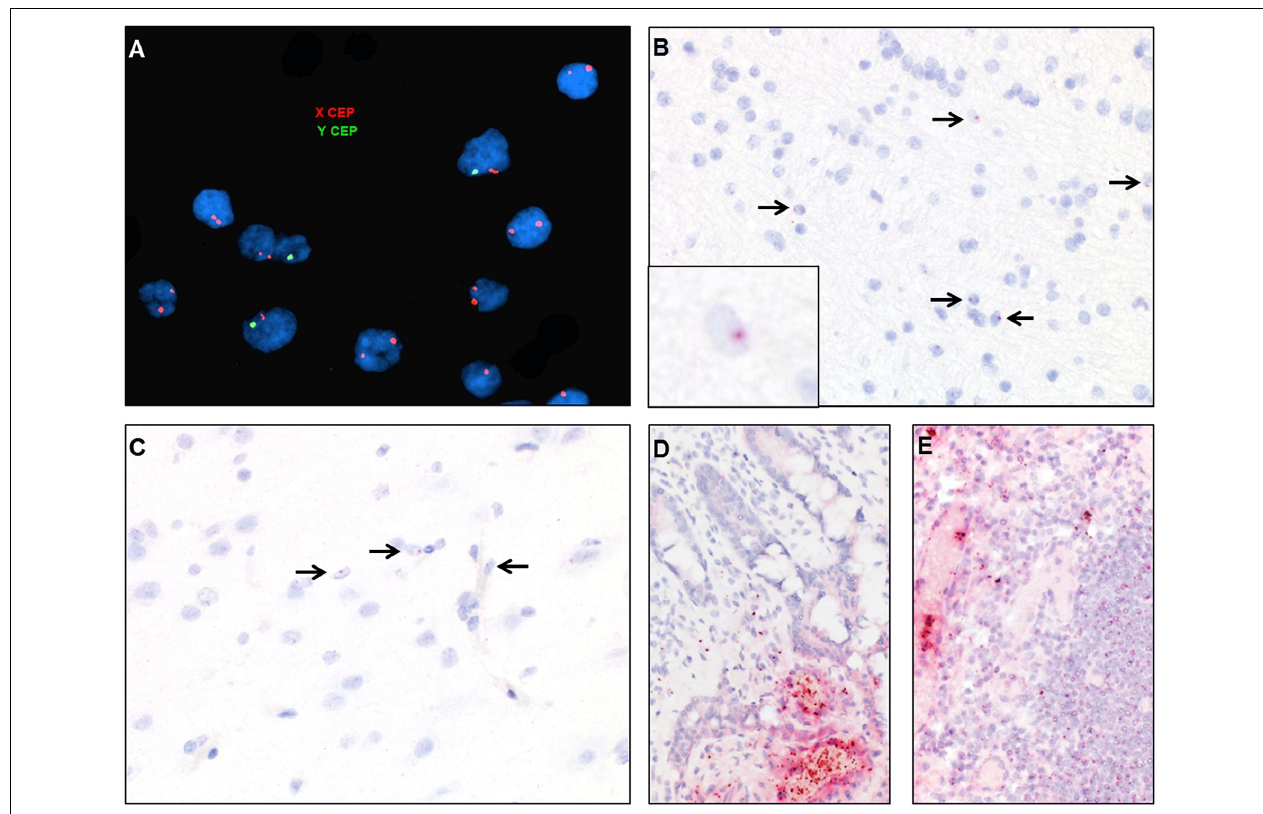
FIGURE 7 | Identification of donor-derived male cells by DNA in situ hybridization with X (red) and Y (green) centromere probes of the white matter of case 2 (A) and by RNA in situ hybridization with Y-specific probes (red) and hematoxylin counterstain of cortical white matter (B) , cortical gray matter (C) , small bowel (D) , and lymph node (E) . Arrows point to scattered cells with small dot-like positive